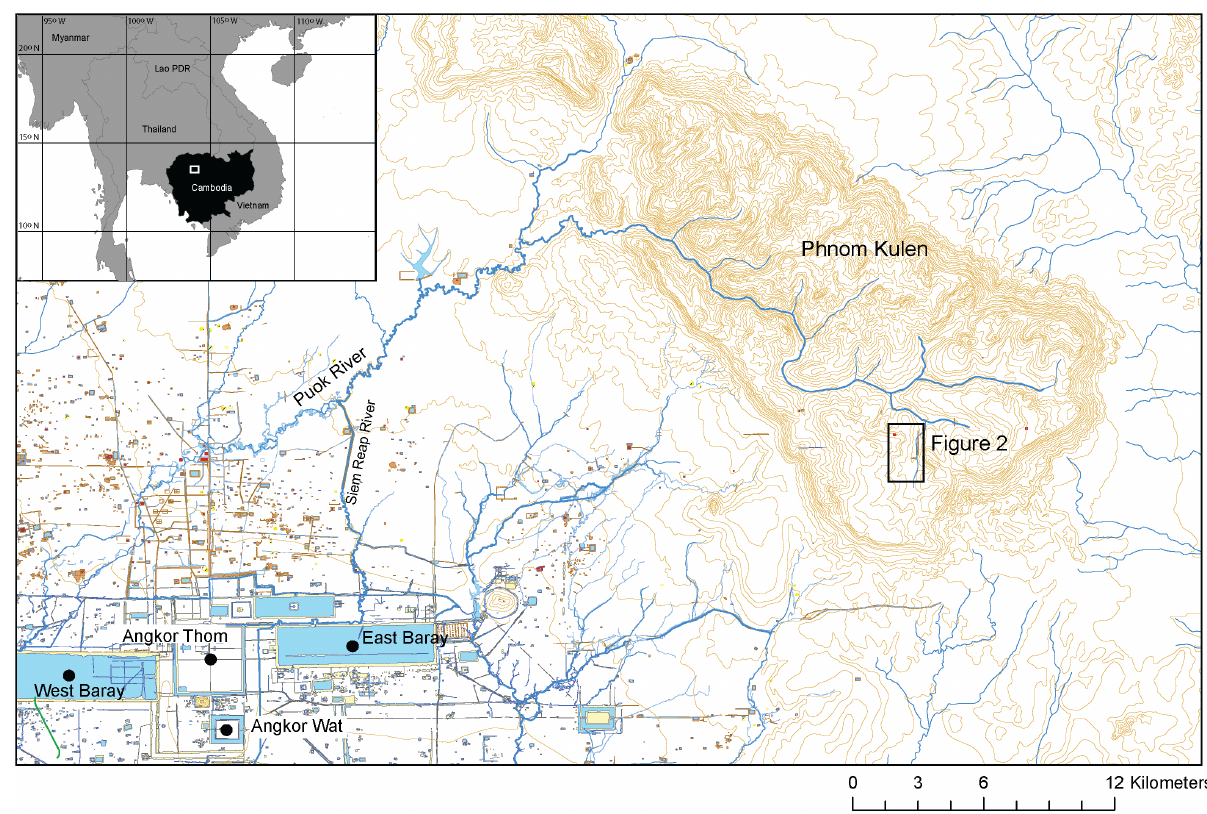
Figure 1. Map of central/northern Angkor and Phnom Kulen (Mahendraparvata). Contours in 10 m intervals. Archaeological map data from [17] and [1], topography and hydrology data from the Japan International Cooperation Agency